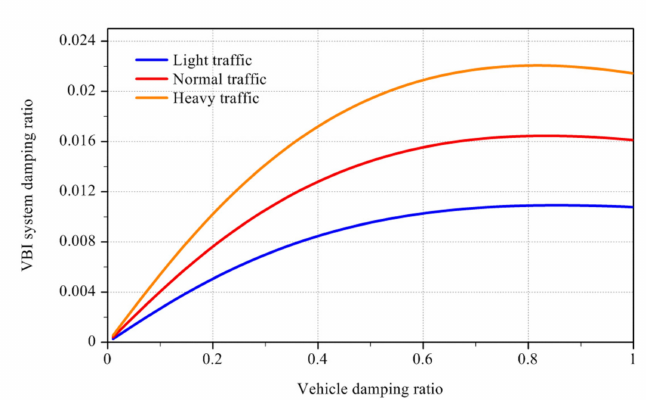
Figure 7. Damping ratio for a VBI